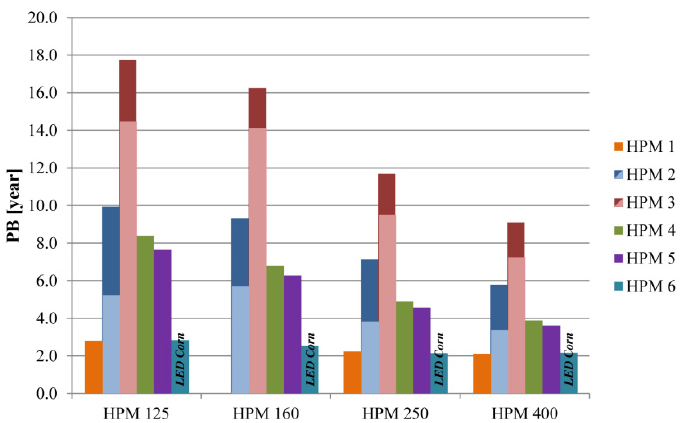
Figure 6. Payback period of proposed energy efficiency measures for HPM lamps.